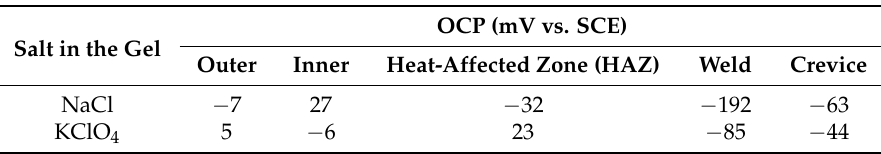
Table 4. OCP measurements performed in the various regions under study for the piece in Figure 1, using gels with 1% NaCl or with 0.5% KClO 4